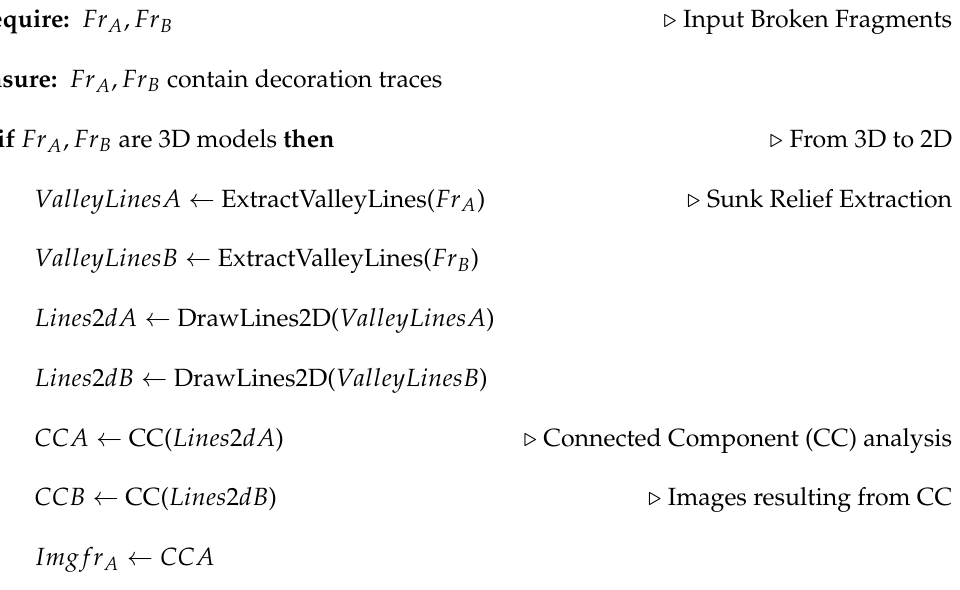
Algorithm 2 General Registration